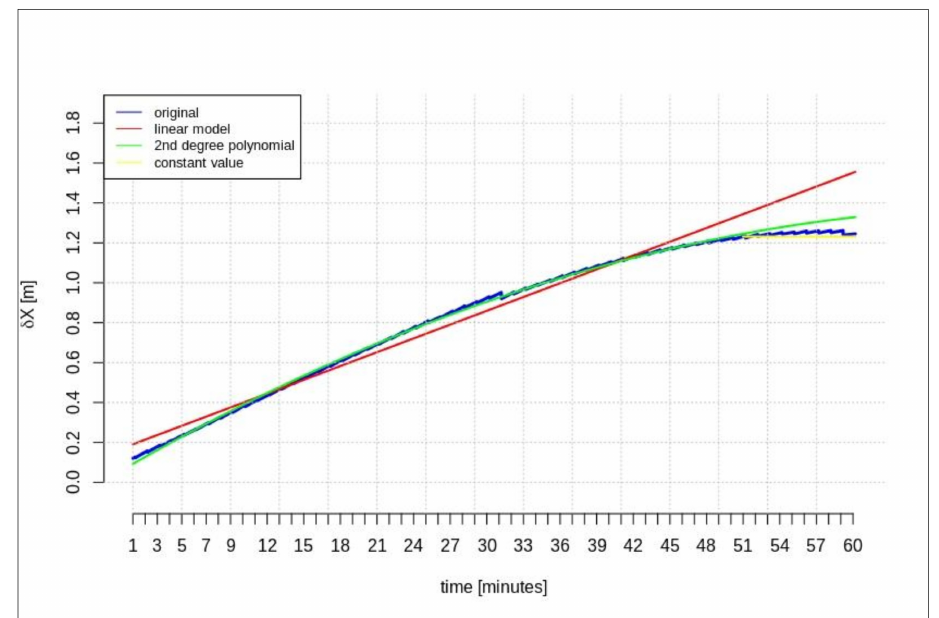
Figure 11. The results of the δ X geocentric correction extrapolation (GPS G28) for a 60-min data-stream between each issue of data ephemeris